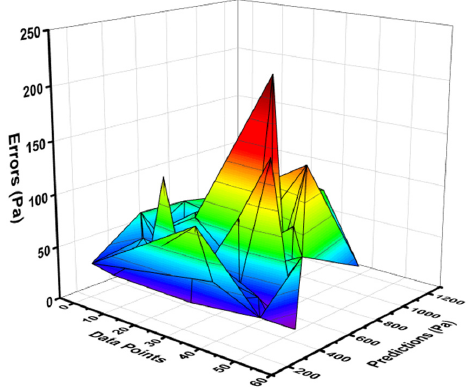
Figure 4. Error distribution of NN model for yield stress.